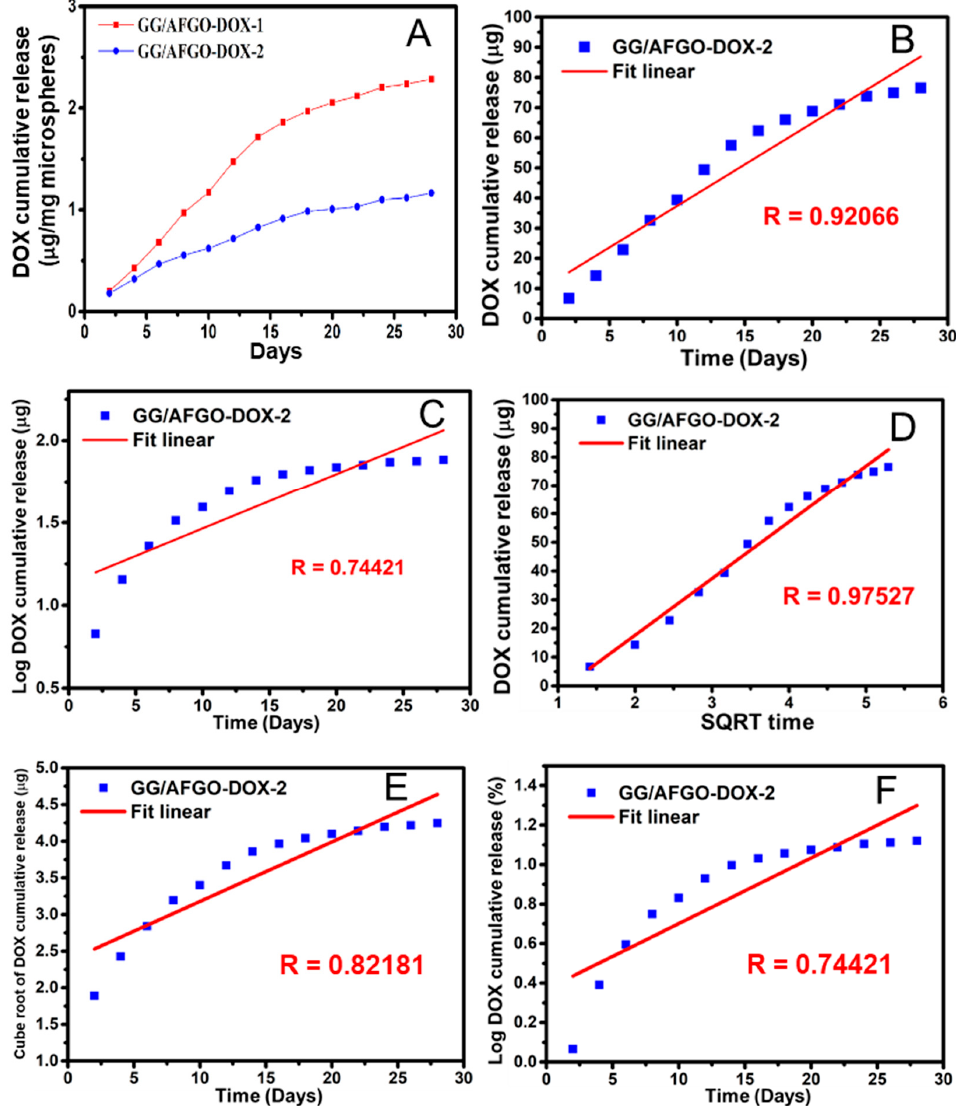
Figure 5. ( A ) Profile of Dox release from the GG/AFGO–Dox-1 (674 ± 43 μ m) and GG/AFGO–Dox-2 (226 ± 15 μ m) over 28 days. Dox release according to the following kinetic models: ( B ) zero, ( C ) first, ( D ) Higuchi, ( E ) Hixson–Crowell, and ( F ) Korsmeyer–Peppas.